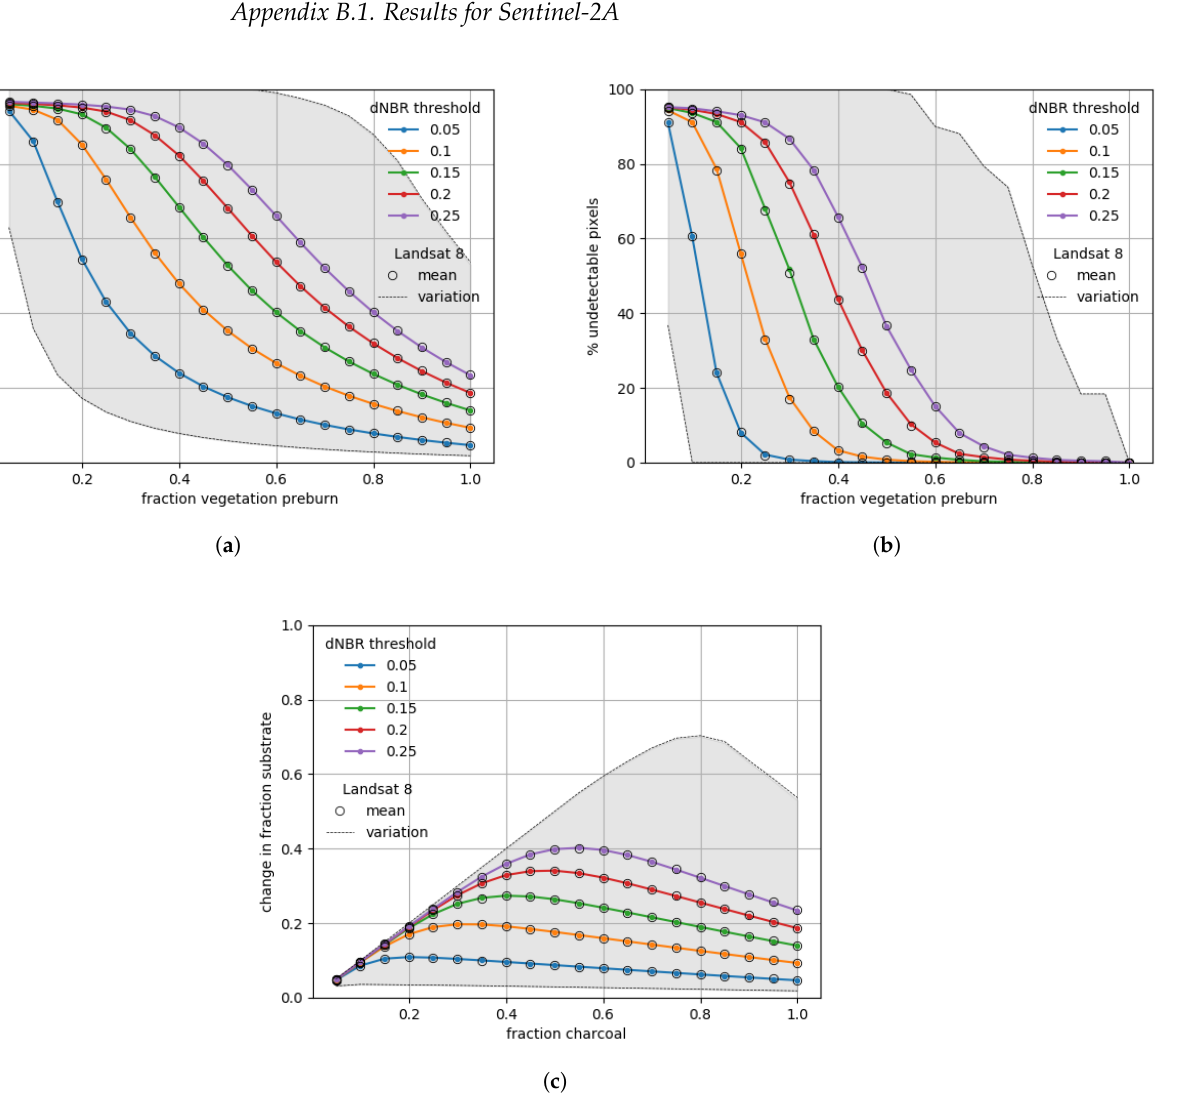
Figure A2. Park-wide detectability results for a pure burn scenario (where loss of vegetation fraction results in equal increase in charcoal fraction ( ∆ char = 1), Sentinel-2A. The mean values are shown in colored lines, with total model result variation shown in gray. To compare, the results for Landsat 8 are shown in black, with mean values shown by circles and total model result variation shown by dashed lines. ( a ) Fraction of vegetation burned at detection. ( b ) Percentage of undetectable pixels. ( c ) Charcoal contribution on